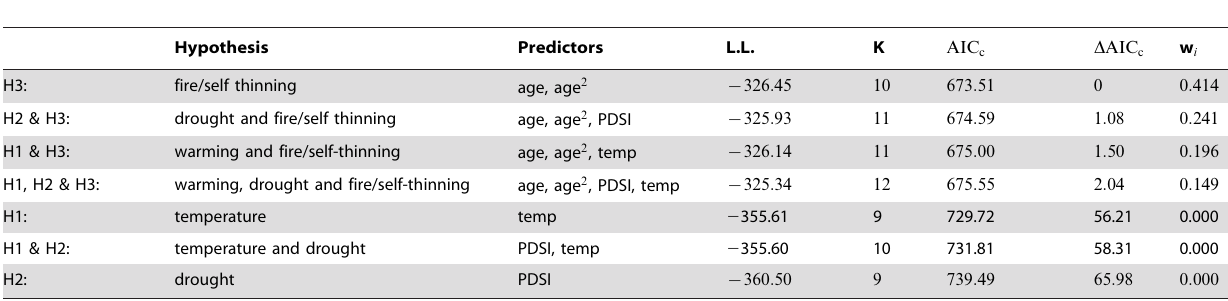
Table 2. Model selection results based on generalized least squares mixed effects models of per-capita mortality rates.